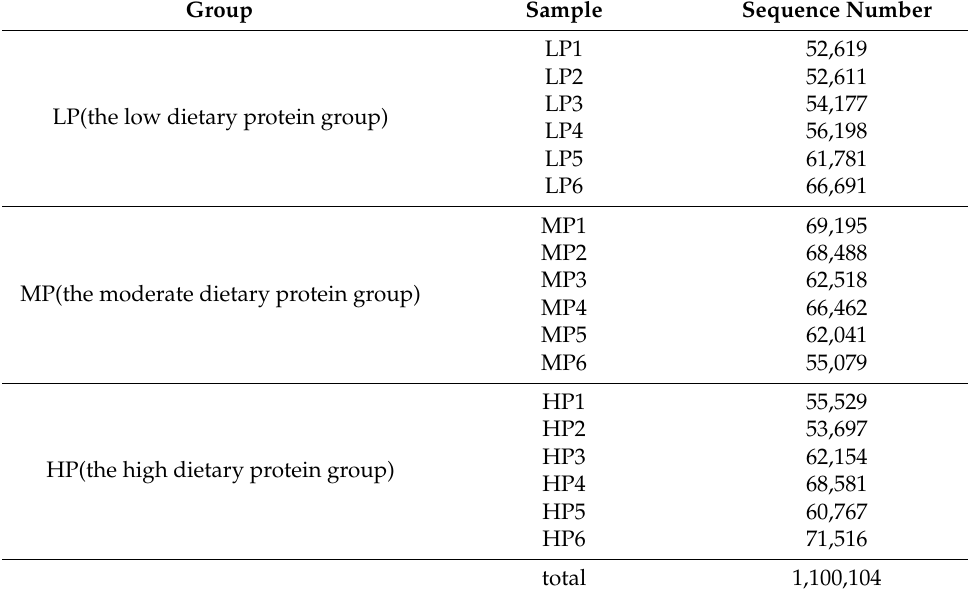
Table 4. Sequencing number per